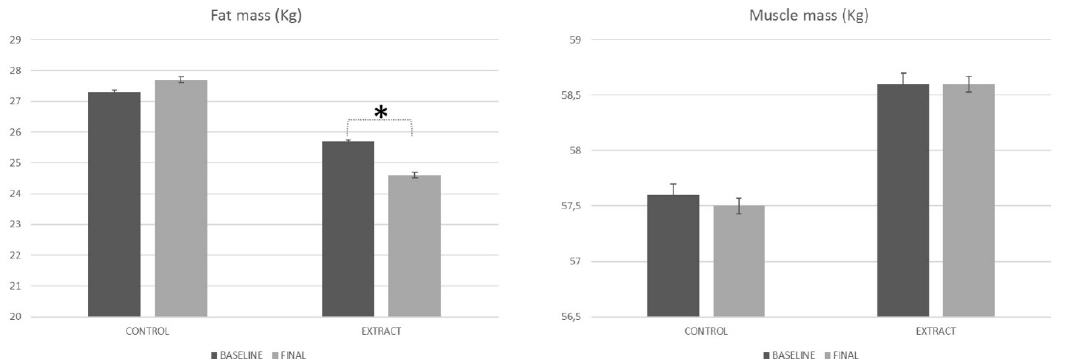
Figure 3. Body composition evolution along the study, measured by bioimpedance. * Means statistically significant differences.